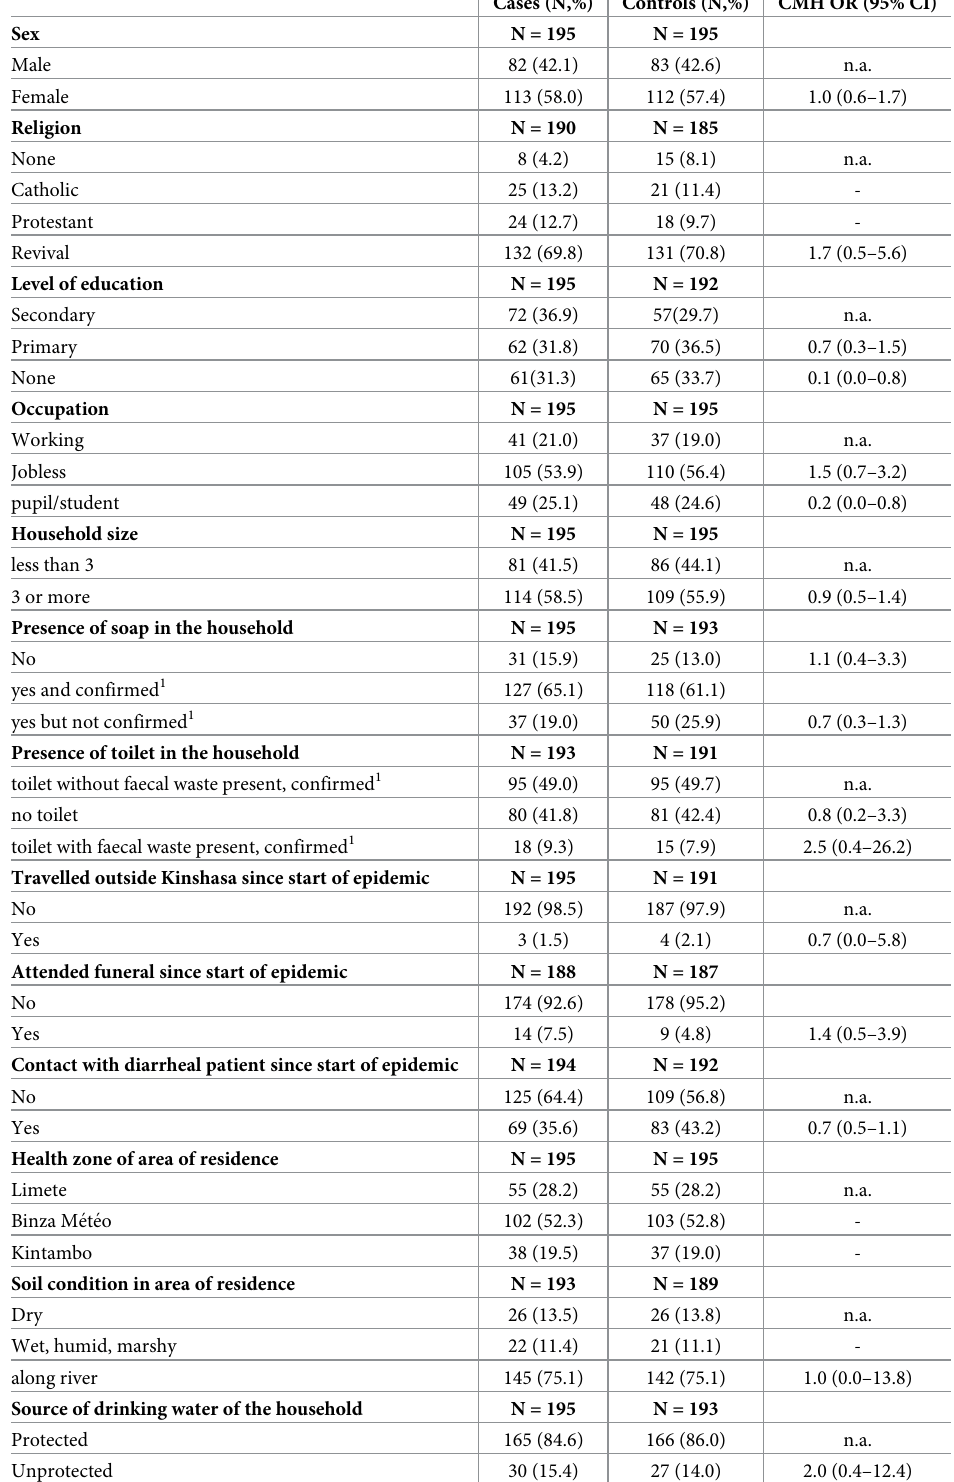
Table 1. Univariate